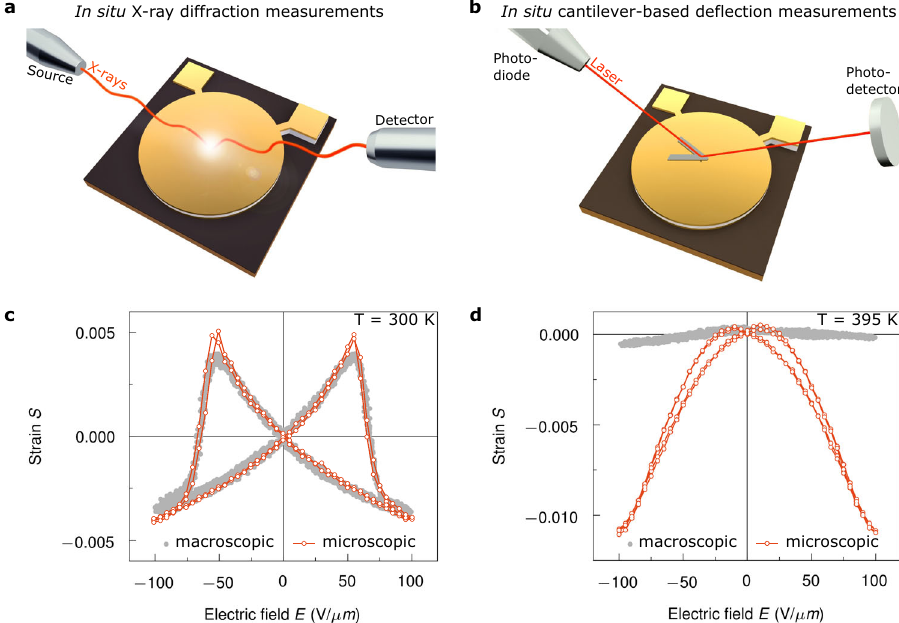
Fig. 5 Macro- and microscopic electromechanical response of P(VDF-TrFE). a In situ grazing incidence XRD measurements were performed to probe the microscopic strain behaviour of the semi-crystalline P(VDF-TrFE) as a function of applied electric fi eld. b To reveal the macroscopic strain behaviour of the crystalline domains during electrical stimulation, we have performed in situ cantilever-based de fl ection measurements. c Comparison of the macro- and microscopic strain behaviour S as a function of the applied electric fi eld E for the low-temperature ferroelectric state at 300 K. d Comparison of the macro- and microscopic strain behaviour S as a function of the applied electric fi eld E for the high-temperature paraelectric state at 395